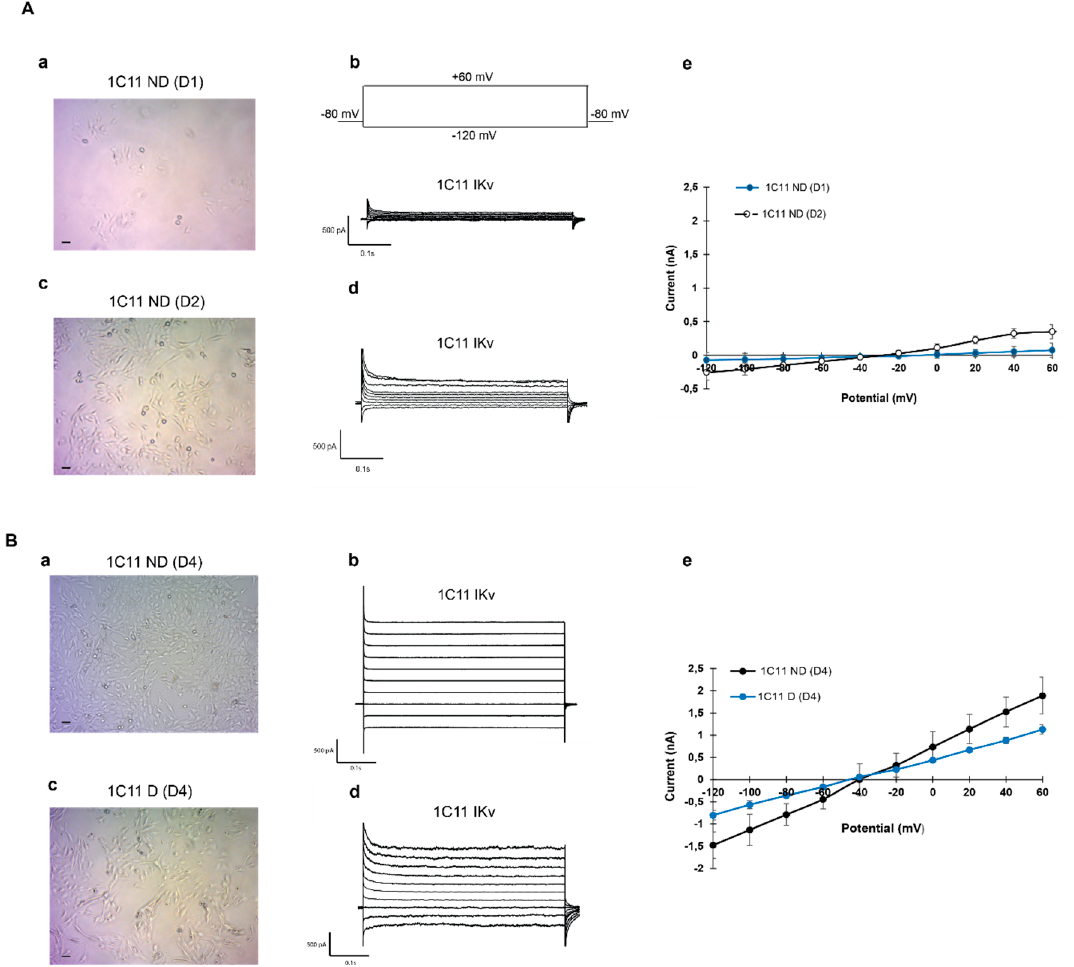
Figure 2. Whole cell potassium channels current recordings in 1C11 cell lines ( A ) 1C11ND(D1) are round ( a ) on day 1 and present a minority potassium current: IKv ( b ). 1C11ND(D2) developing little ramification in day 2 ( c ) shows a higher current amplitude under the same conditions ( d ). Current–potential relationships in 1C11ND(D2) cells are illustrated in ( e ). ( B ) 1C11ND(D4) cells on day 4 ( a ) show the highest potassium current amplitude ( b ). The micrography ( c ) presents differentiated cells1C11D(D4) in the presence of precursors cultured in the same conditions and with potassium